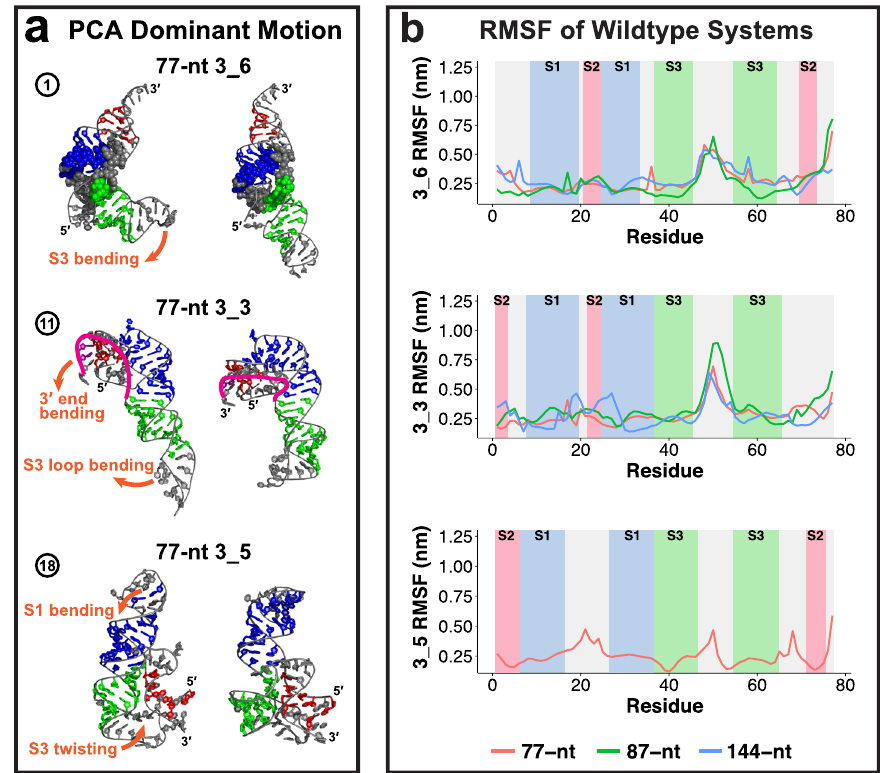
Fig. 6 Dynamic analysis of the wildtype 3_6, 3_3, and 3_5 systems. a Dominant motions of the threaded L shape 77-nt 3_6 pseudoknot, 77-nt 3_3 pseudoknot, and 77-nt compact 3_5 junction extracted by principal component analysis (PCA). b Flexibility of the three conformations as re fl ected by root mean square fl uctuations (RMSF). For the 3_6 and 3_3 pseudoknots, the RMSF is shown for the common 77-nt region at various lengths; for 3_5 junction, RMSF at 77-nt. The different stem regions are colored and labeled.